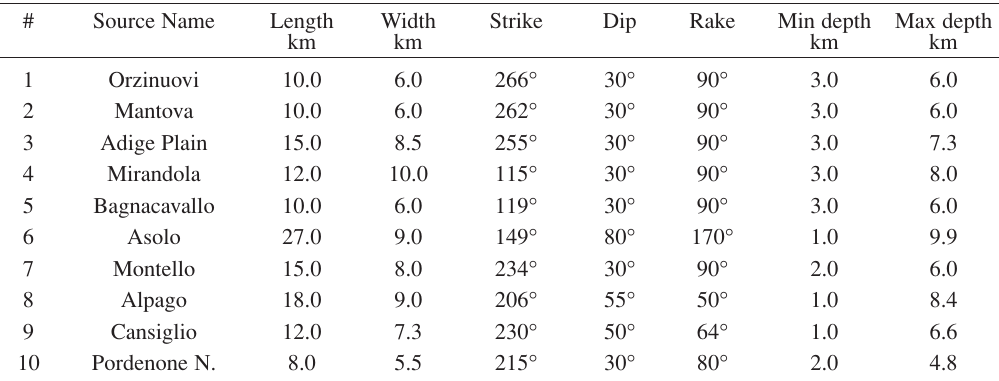
Table II. Parameters of the seismogenic sources of the Po and Veneto plains included in the Database of Potential Sources for Earthquakes larger than M 5.5 in Italy (Valensise and Pantosti, 2001b). Each source is keyed to fig. 1a,b through a code. The Orzinuovi seismogenic source (# . 1) is related to the 12 May 1802 Oglio Valley earthquake, and was identified through the geomorphological approach presented in this work. Its geo- metrical and kinematic parameters were used for the dislocation modelling (see fig.